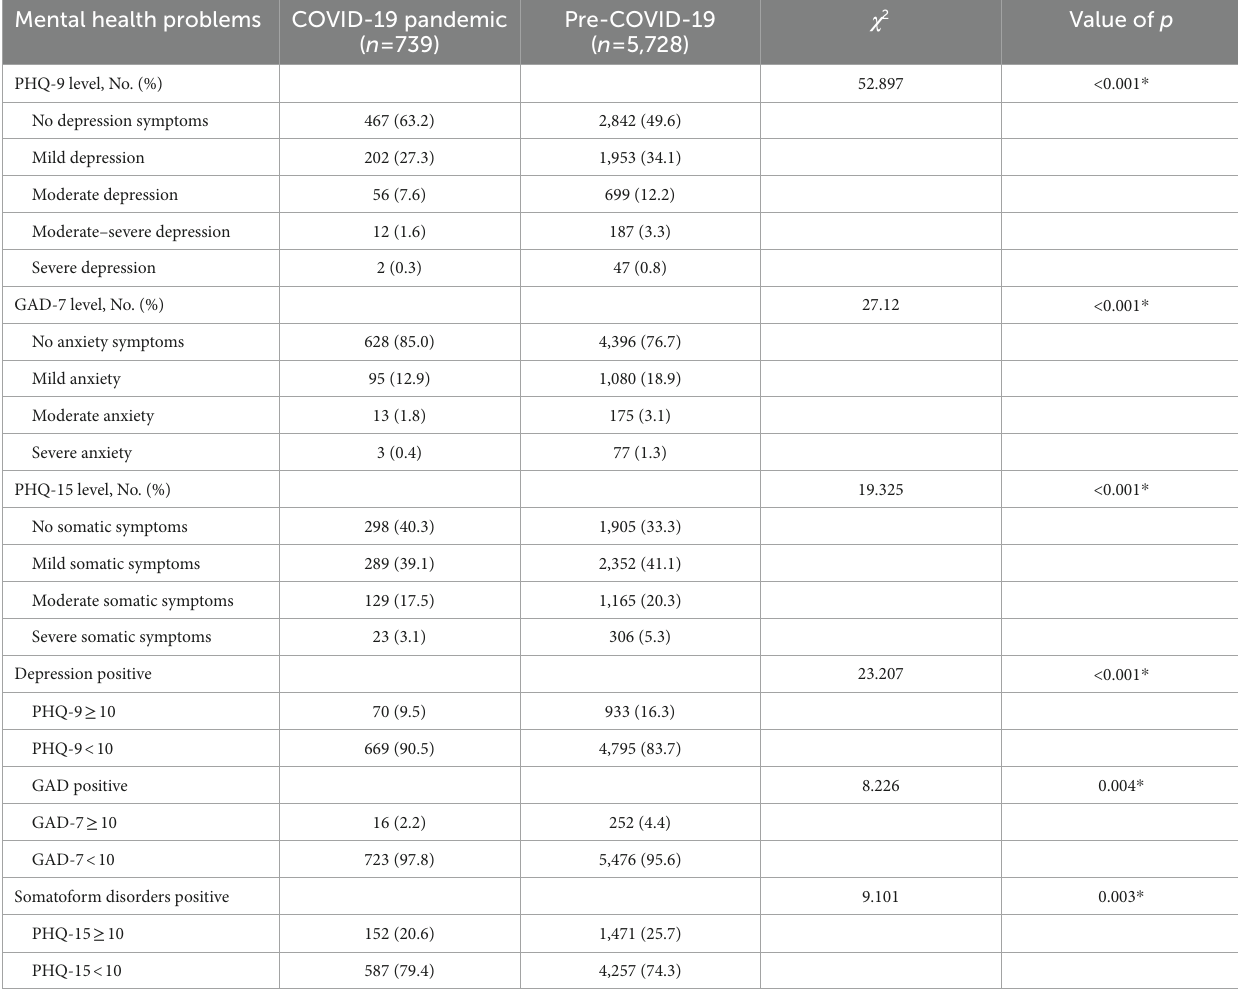
TABLE 2 Results of PHQ-9, GAD, and PHQ-15 between the two groups. Mental health